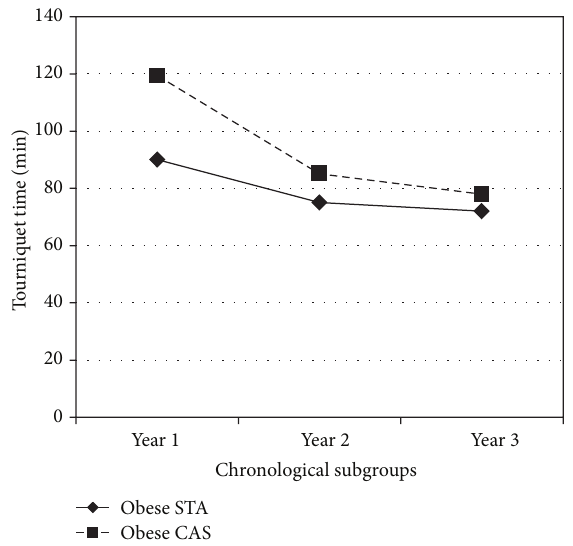
Figure 2: Tourniquet times of obese STA and obese CAS TKR over three chronological periods (designated as year as the periods were roughly a year each).